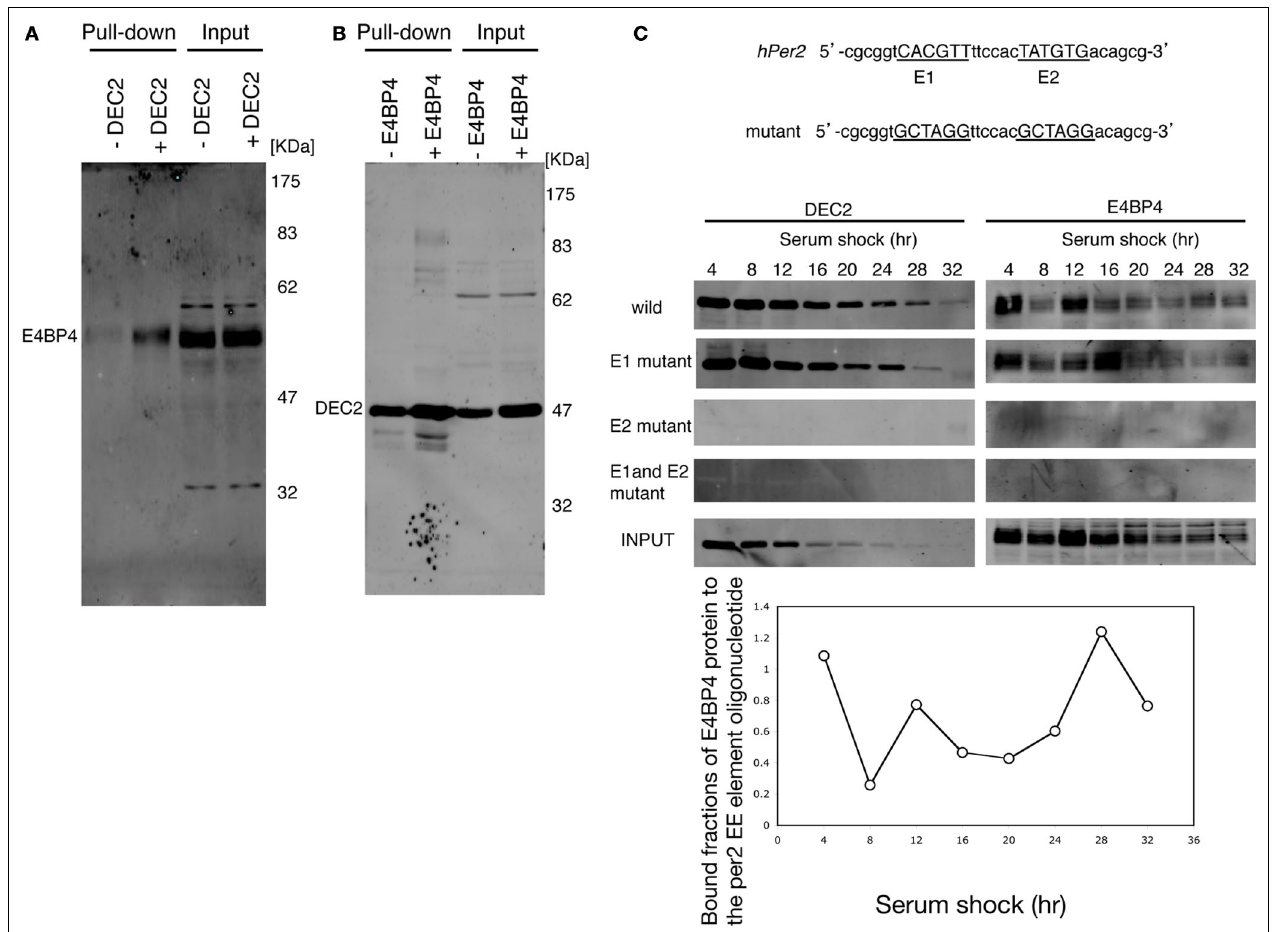
expressing only DEC2 and co-expressing DEC2 and E4BP4, indicated with (cid:0) E4BP4 and + E4BP4, respectively. (C) DEC2–E4BP4 heterodimer binds the E2 consensus of Per2 EE element. DEC2–E4BP4 heterodimer was pulled down from nuclear extracts of NIH3T3 cells co-expressing DEC2 and E4BP4 every 4-h after cyclohexylamine-shock. Detection of E4BP4 or DEC2 was performed using immunoblotting with DEC2 (left panel) and E4BP4 (right panel). Both DEC2 and E4BP4 were pulled down by wild-type and the E1 mutant probes but not by E2 mutant and E1-E2 mutant probes. Wild-type and mutant sequences of Per2 EE element probe are shown in the upper panel. Representative results of three independent experiments are shown. The bottom figure shows the quantification of bound fractions of E4BP4 to the wild-type per EE